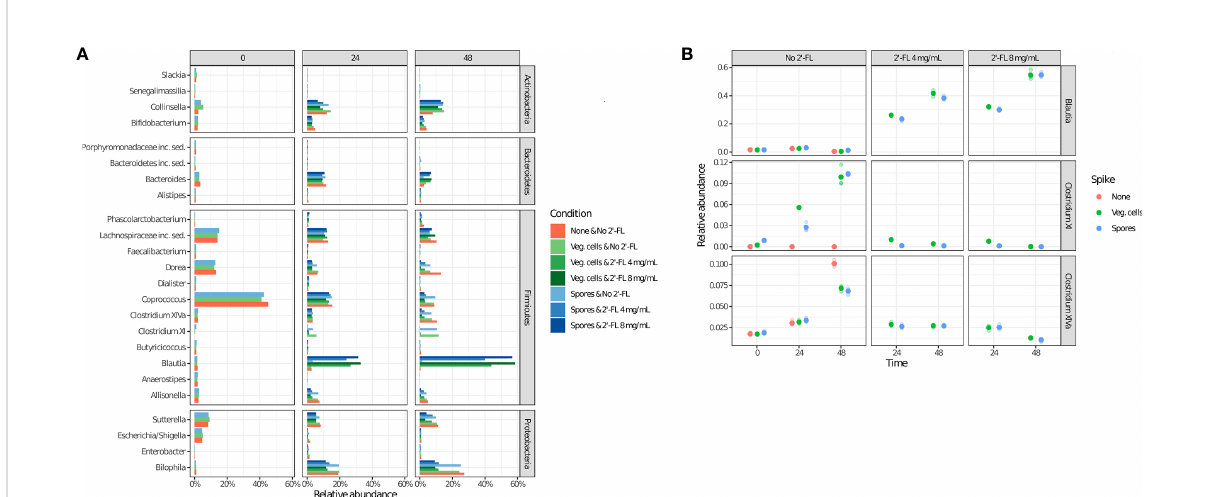
FIGURE 4 2 ’ -FL changes the relative abundance of speci fi c genera in the CDi-screen over time. Microbial community composition as determined via 16S rRNA gene sequencing is displayed as relative abundance at the genus level. The community composition dynamics throughout the incubation were investigated at the time points 0 h, 24 h, and 48 h, as indicated, without or with 2 ’ -FL at a concentration of 4 mg/mL or 8 mg/mL. The absence (red circles) or presence of C dif fi cile ATCC 43599 inoculated as vegetative cells (green circles) or spores (blue circles) is shown. (A) The relative abundance of the top 25 most abundant genera under all experimental conditions (shown on the right). (B) Relative abundances of the selected genera Clostridium cluster XI (which includes C dif fi cile ), Blautia , and Clostridium cluster XIVa (extracted from the source data for Figure